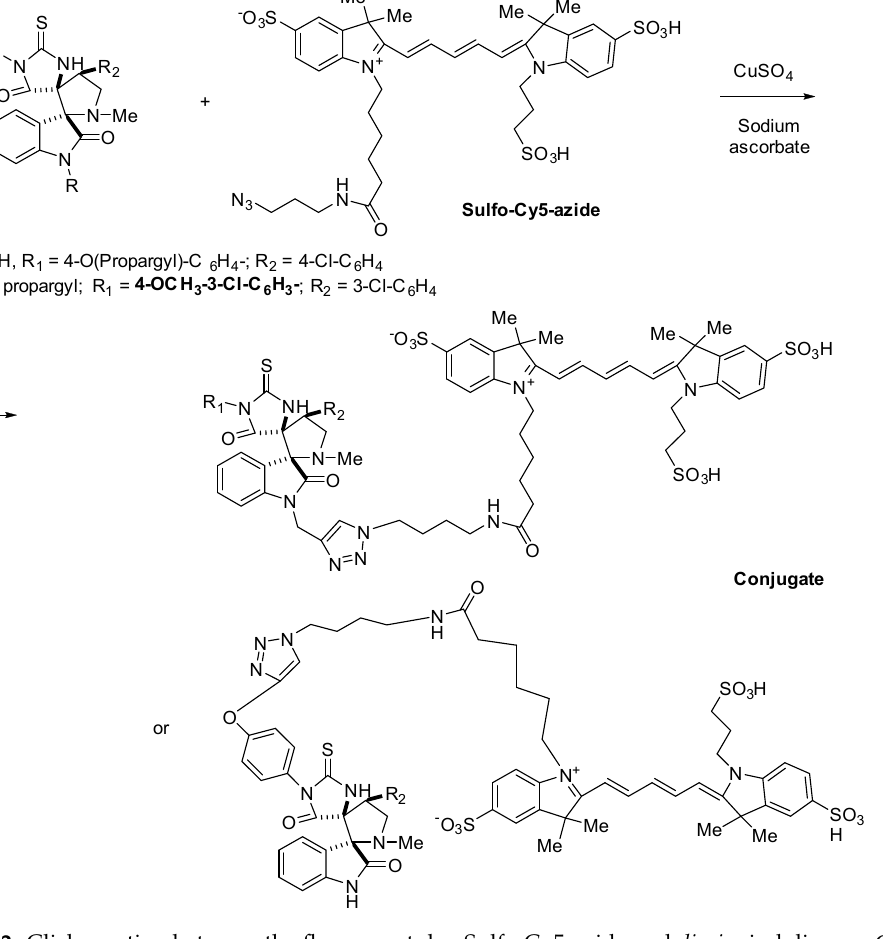
Figure 7. The localization of the compound 35 –Sulfo-Cy5-azide conjugate in 22RV1 cells (( left ) stained by click reaction product; ( right ) Sulfo-Cy5-azide only).